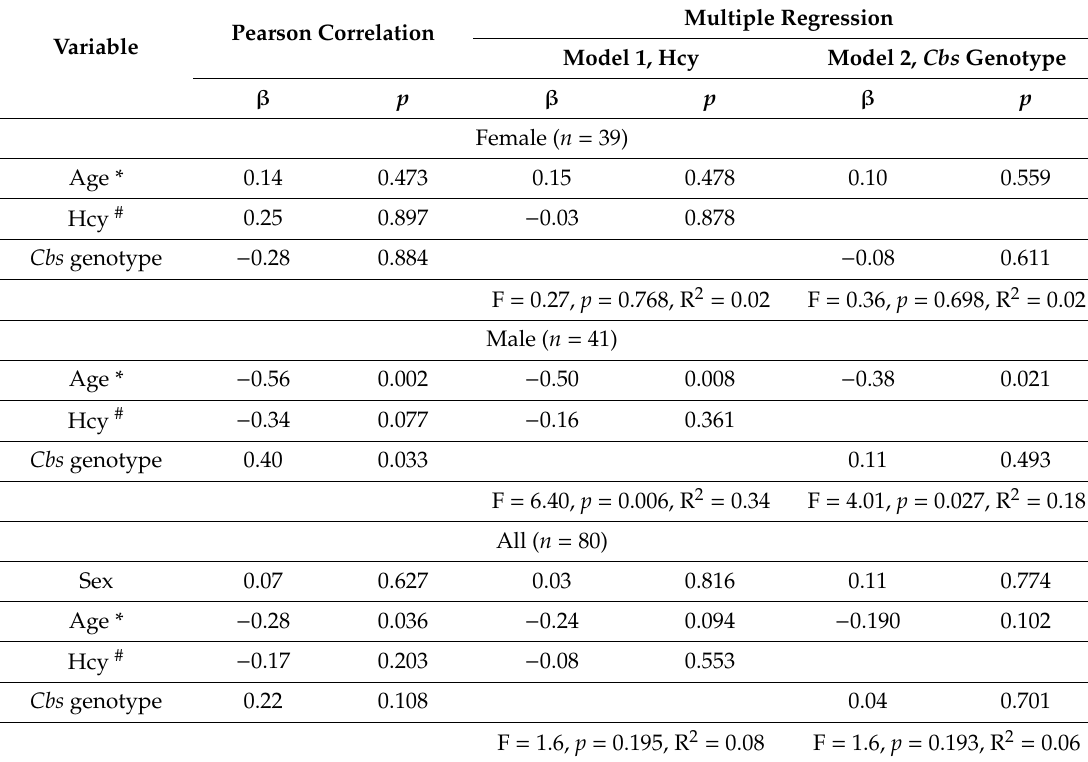
Table 1. Determinants of blood TL in a combined cohort of Cbs − / − and Cbs +/ − mice. Pearson Correlation Variable